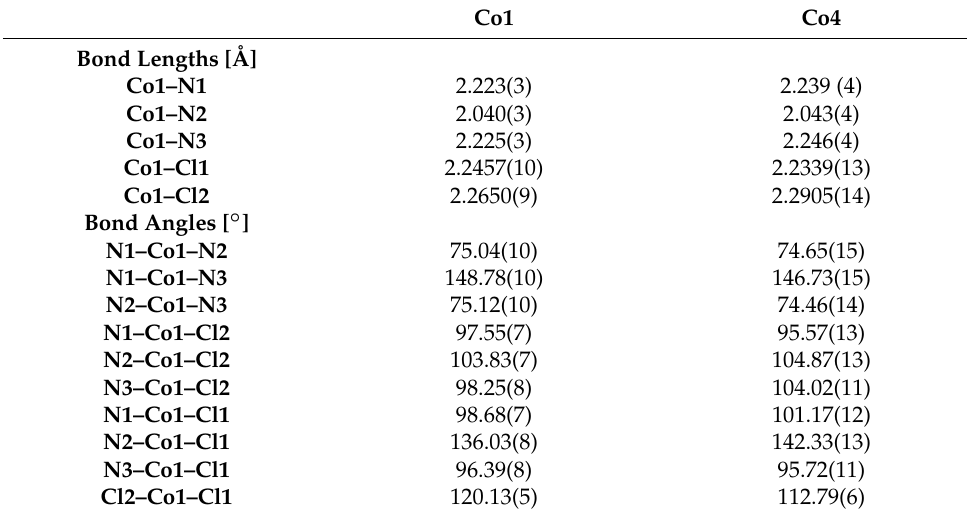
Table 1. Selected bond lengths and bond angles for Co1 and Co4